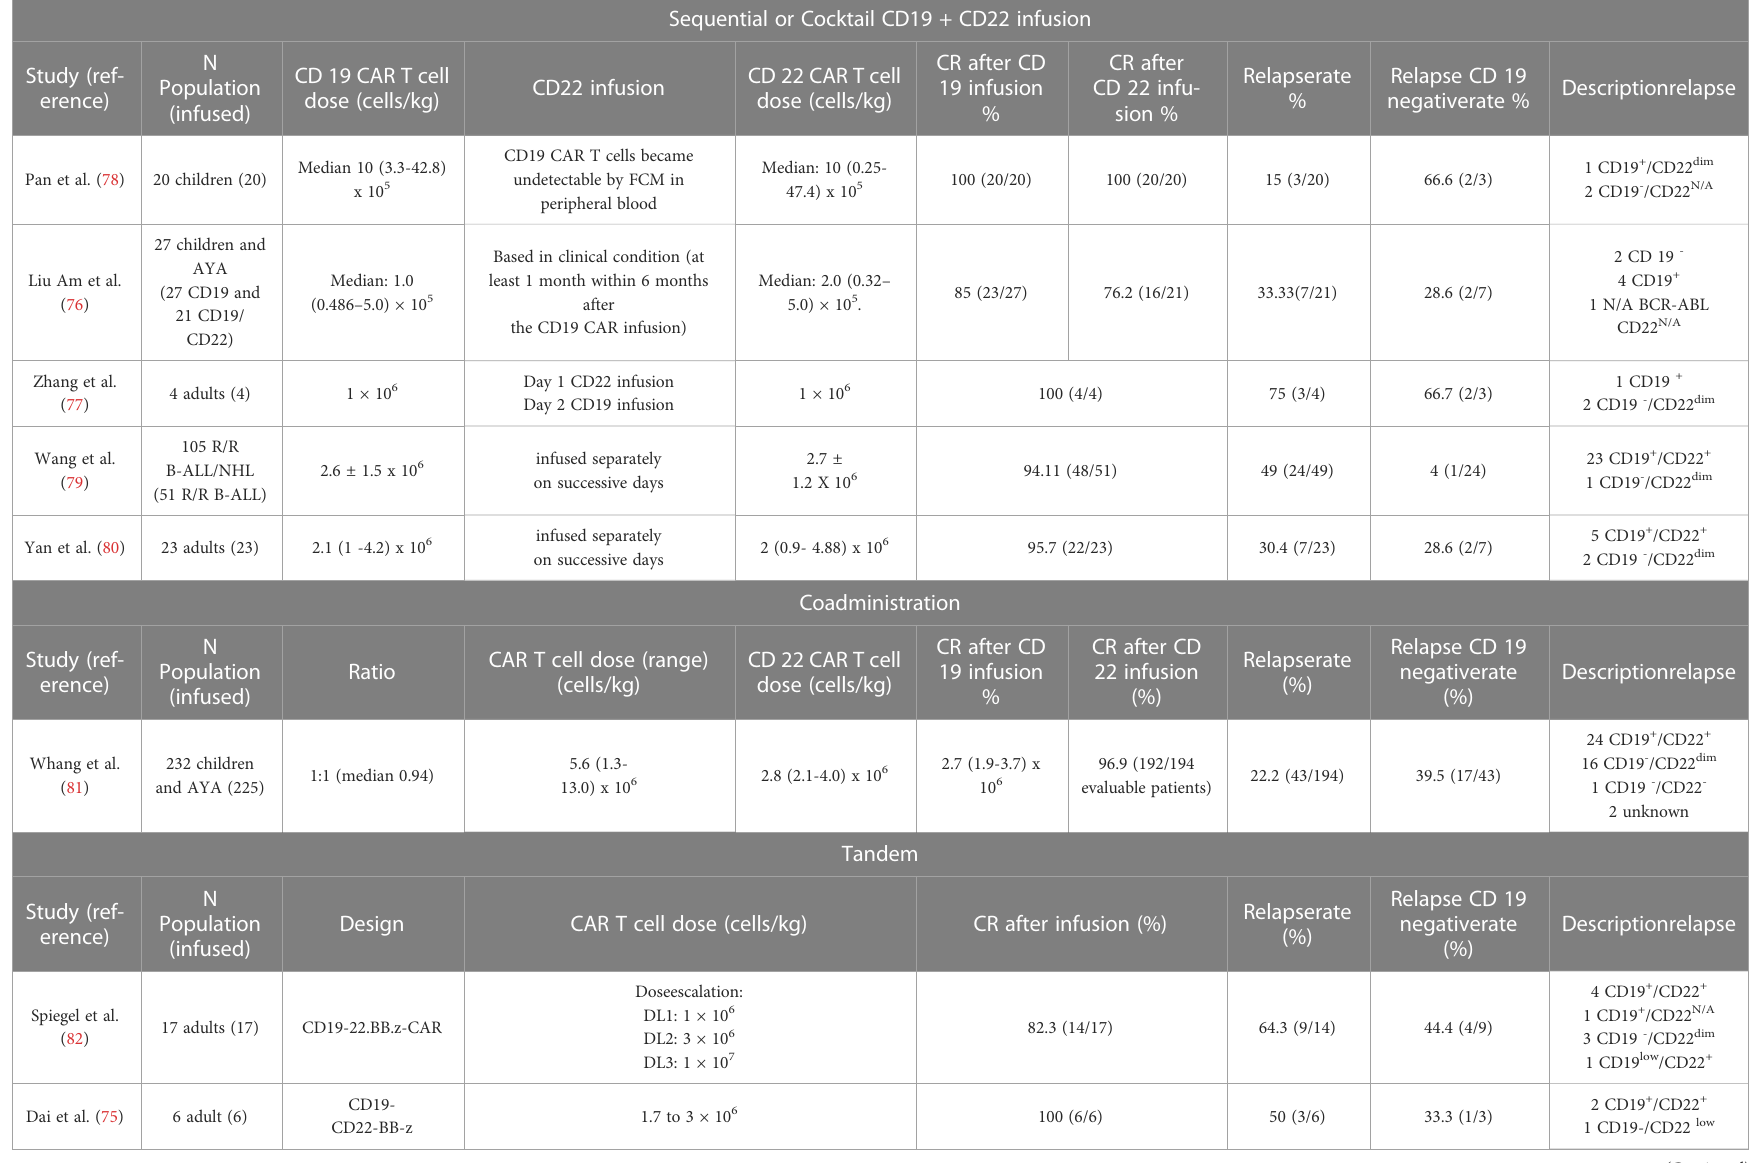
TABLE 2 Clinical outcomes after CD19 and CD 22 CAR T cell therapy in patients with R/R B-ALL.